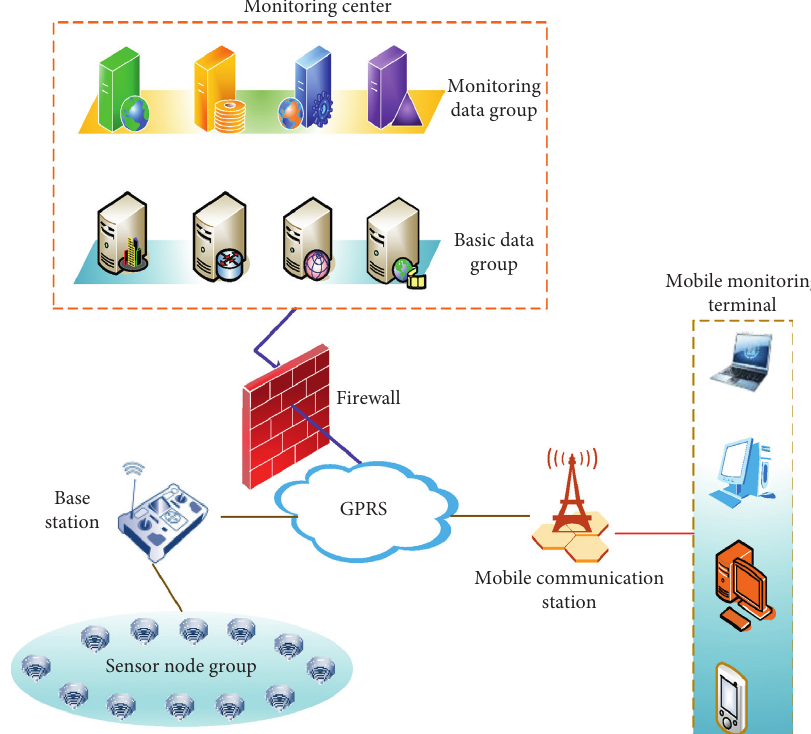
Figure 1: Wireless sensor network system architecture.